Question: In one sentence, what is this figure communicating?
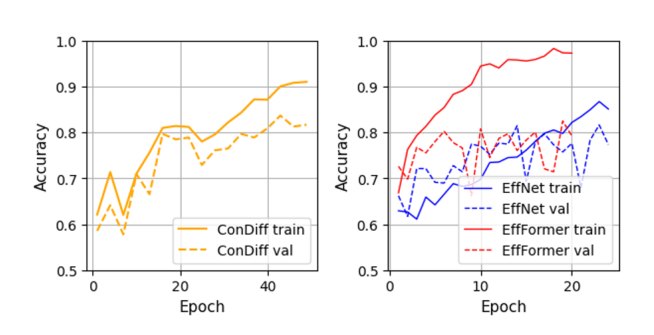
Answer: The learning accuracy trajectories of the ConDiff classifier and best-performing CNN-based (EfficientNet-B0) and ViT-based (EfficientFormer-L1) models, on the train and validation sets.